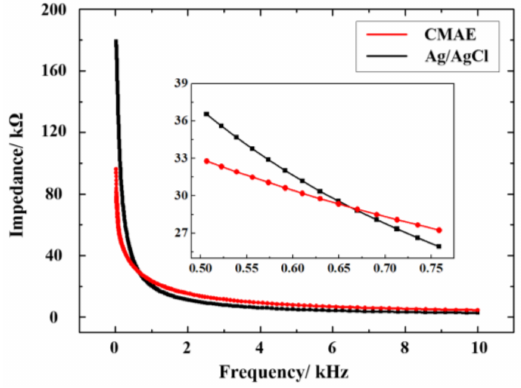
Figure 8. Impedance curve of the CMAE and Ag/AgCl electrode.